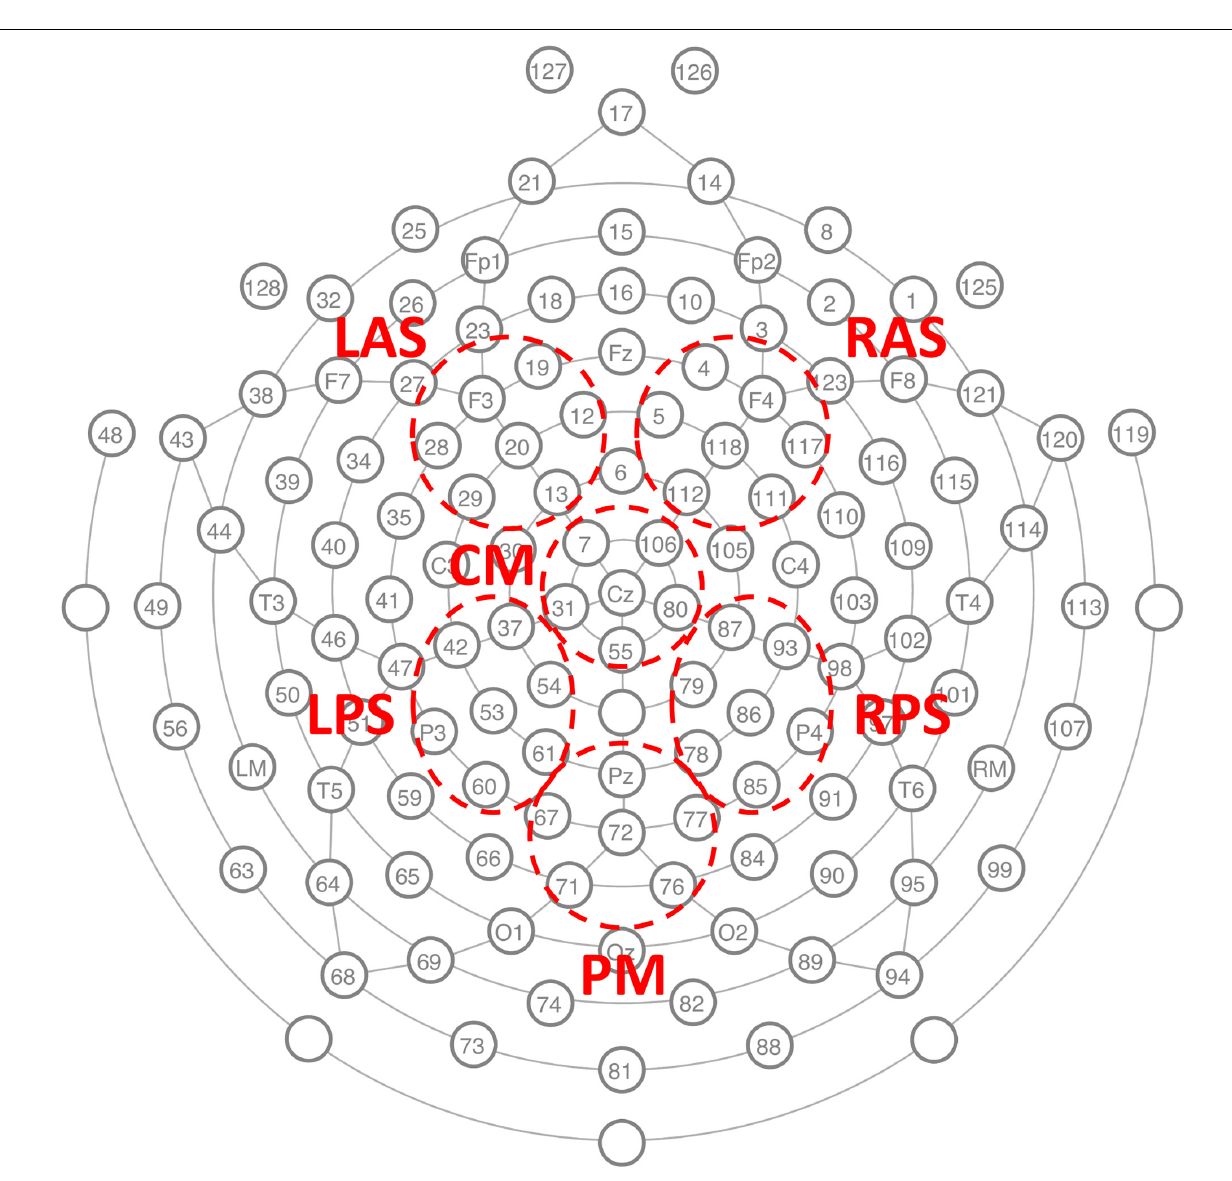
Frontiers in Human Neuroscience |